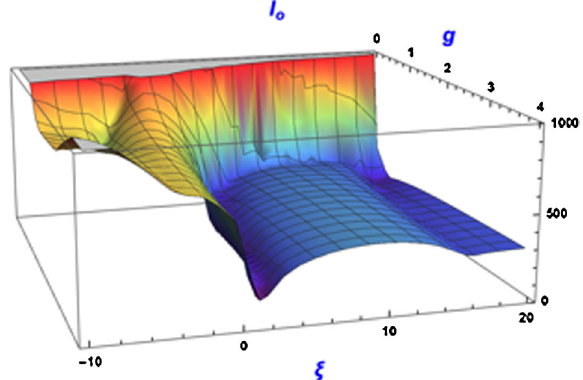
FIG. 31. Same as above, but for the full 25 ns beam. The average linear slope toward higher intensity reflects contribution of the coupled-bunch motion. It can be approximated as Im q (cid:3) ≈ 0 . 075 ImpF